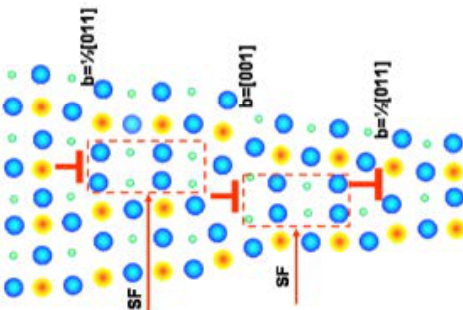
Figure 3. Schematic illustration of the dissociation structure of the [012] dislocation in SrTiO 3 : configuration of the partial dislocations at the boundary. The dashed lines indicate stacking faults (SF). The color coding follows Figure 2. Adapted from [74].